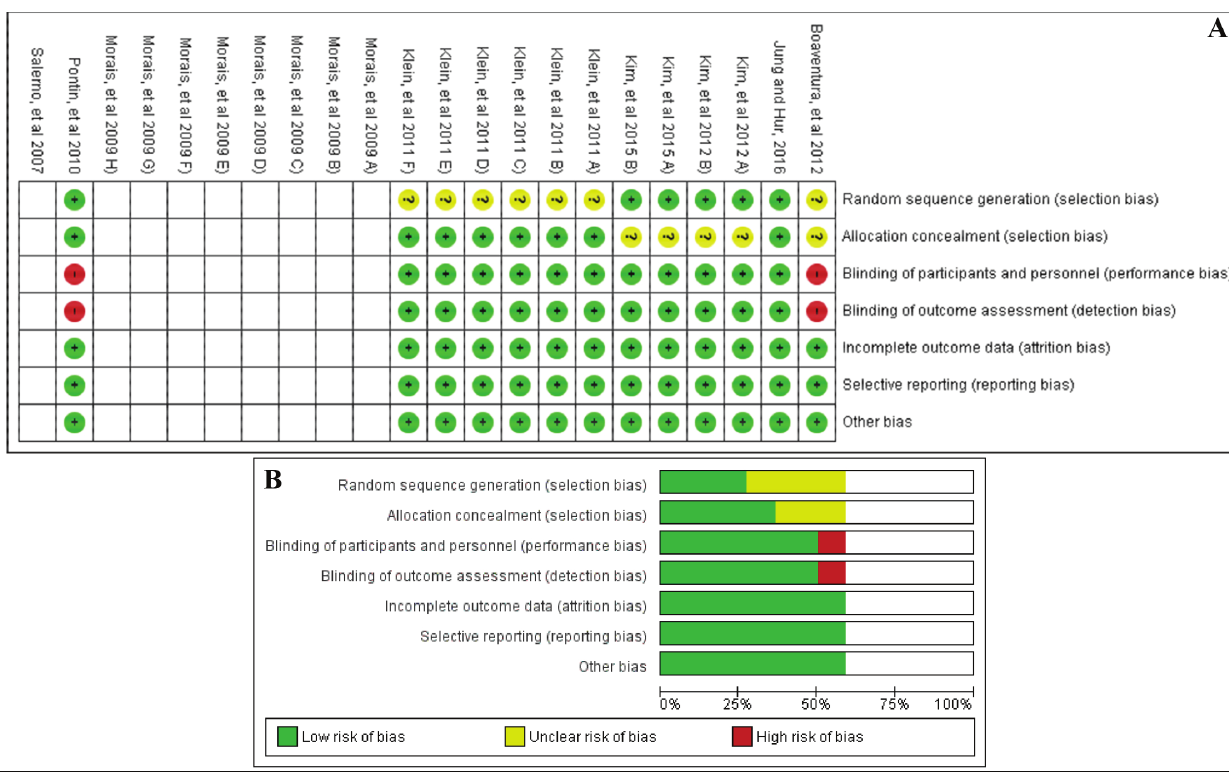
FIGURE 2 - Results of risk of bias assessment regarding the methodological quality of included studies: A) Risk of bias summary: review author’s judgments about each risk of bias item for each included study; B) Risk of bias graph: review author’s judgments about each risk of bias item presented as percentages across all included